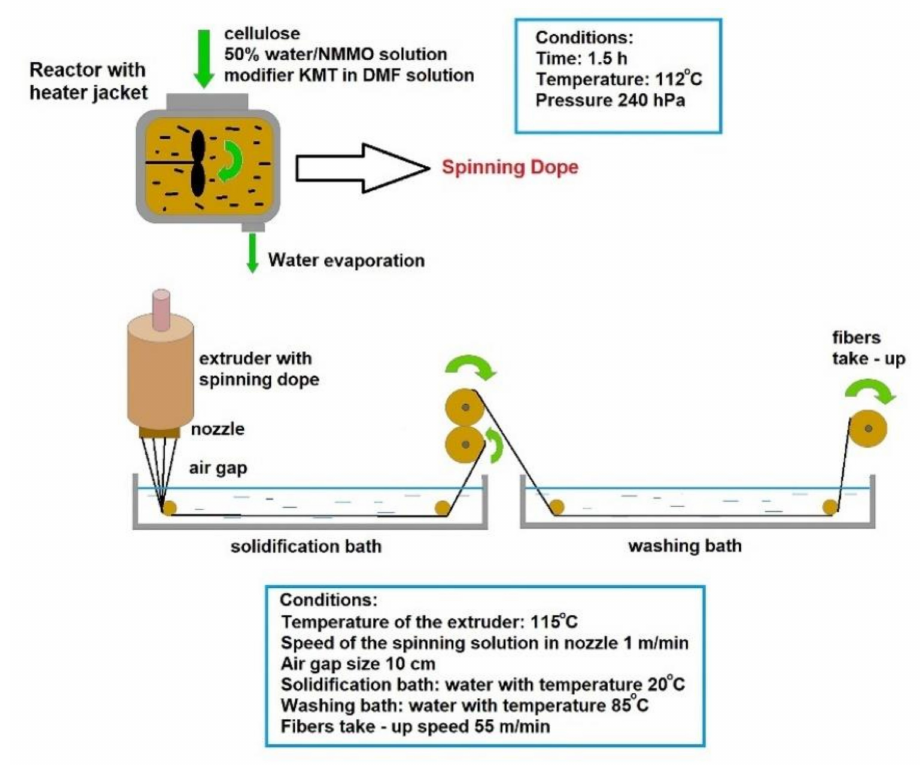
Figure 1. Scheme of man–made cellulose fibers formation in laboratory scale and typical conditions during the